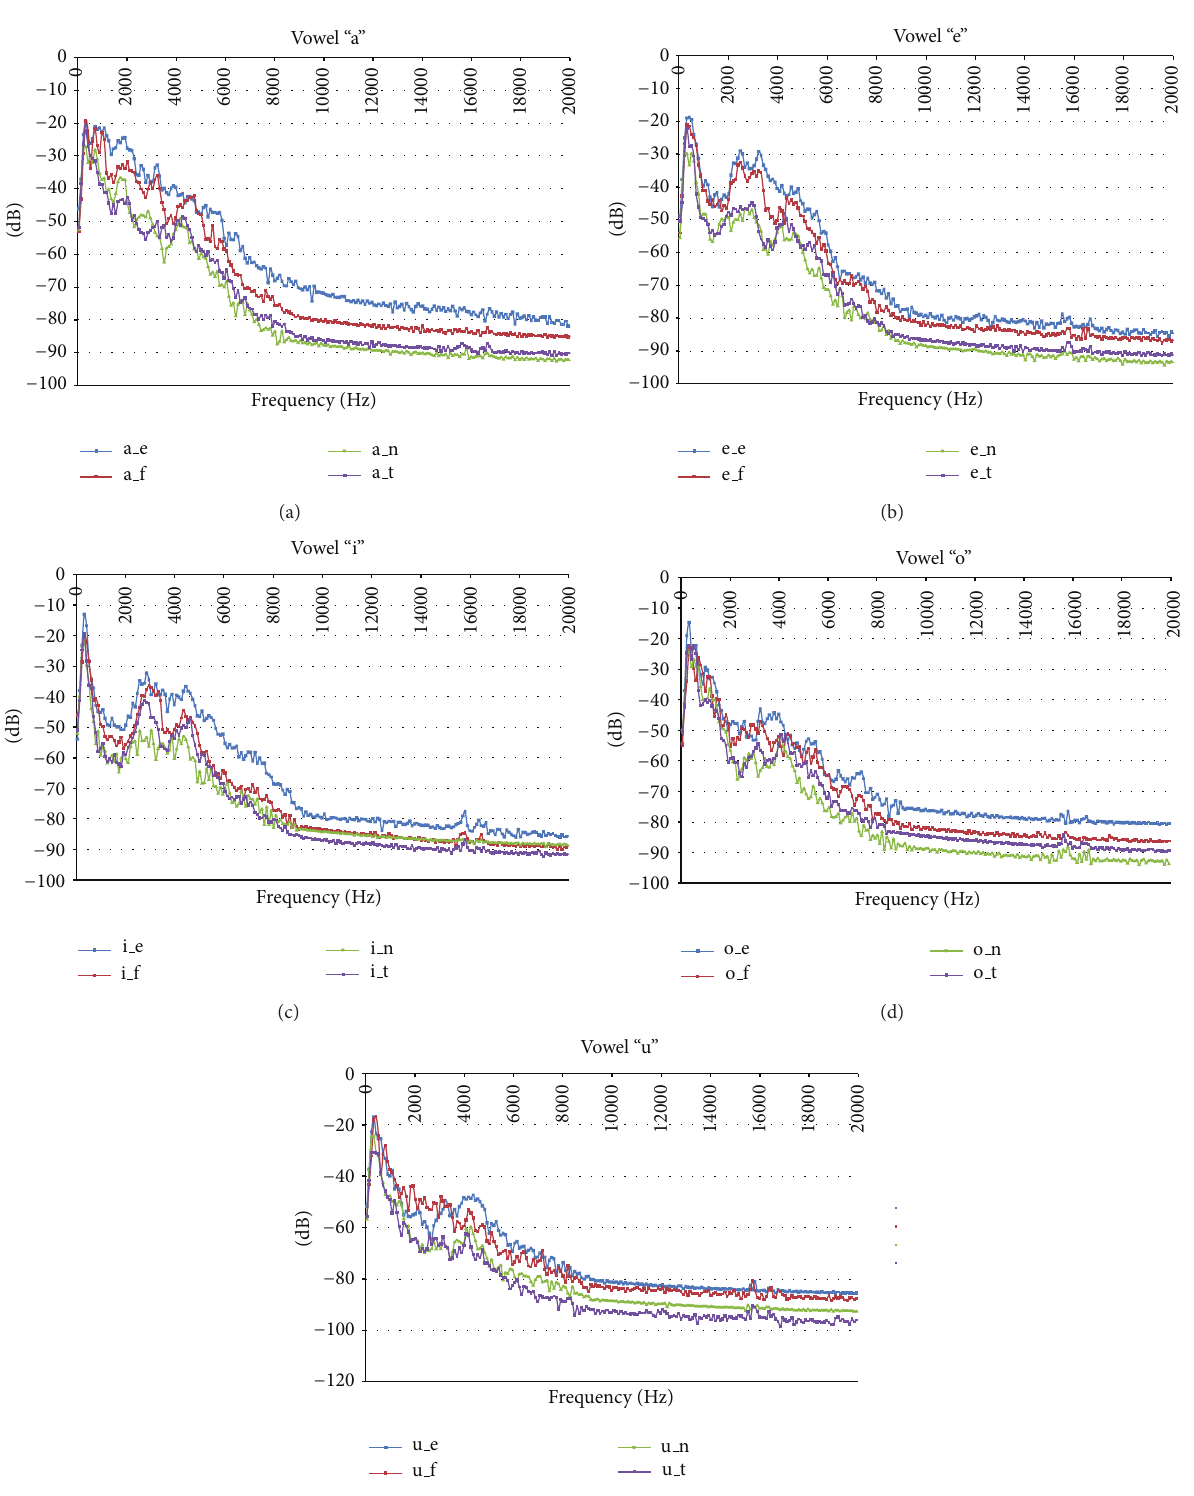
Figure 3: Average spectrum for all emotion-specific vowels across all female speakers. Description of identifiers: e = anger, f = happiness, n = neutral, and t =